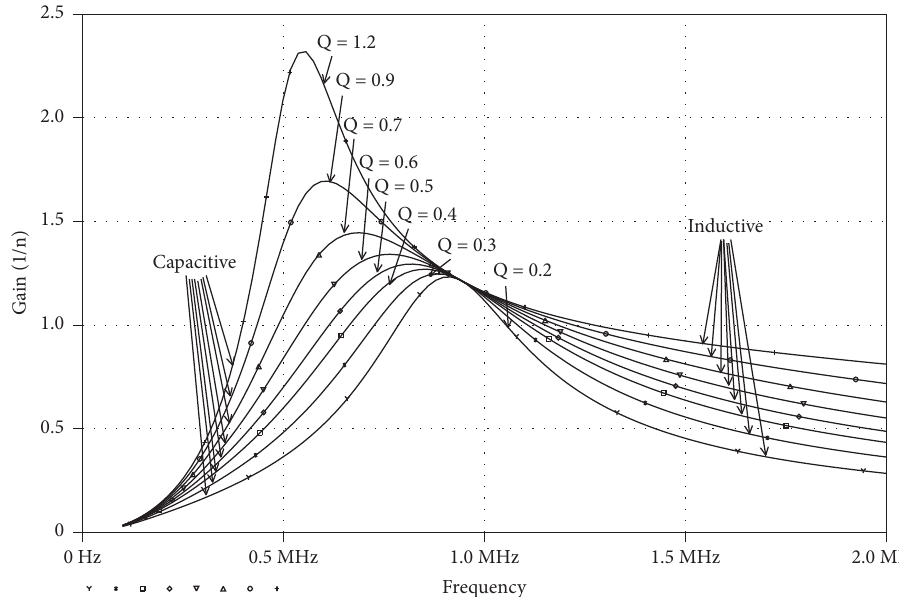
Figure 4: Gain waveforms of CLLL converter for diferent loading